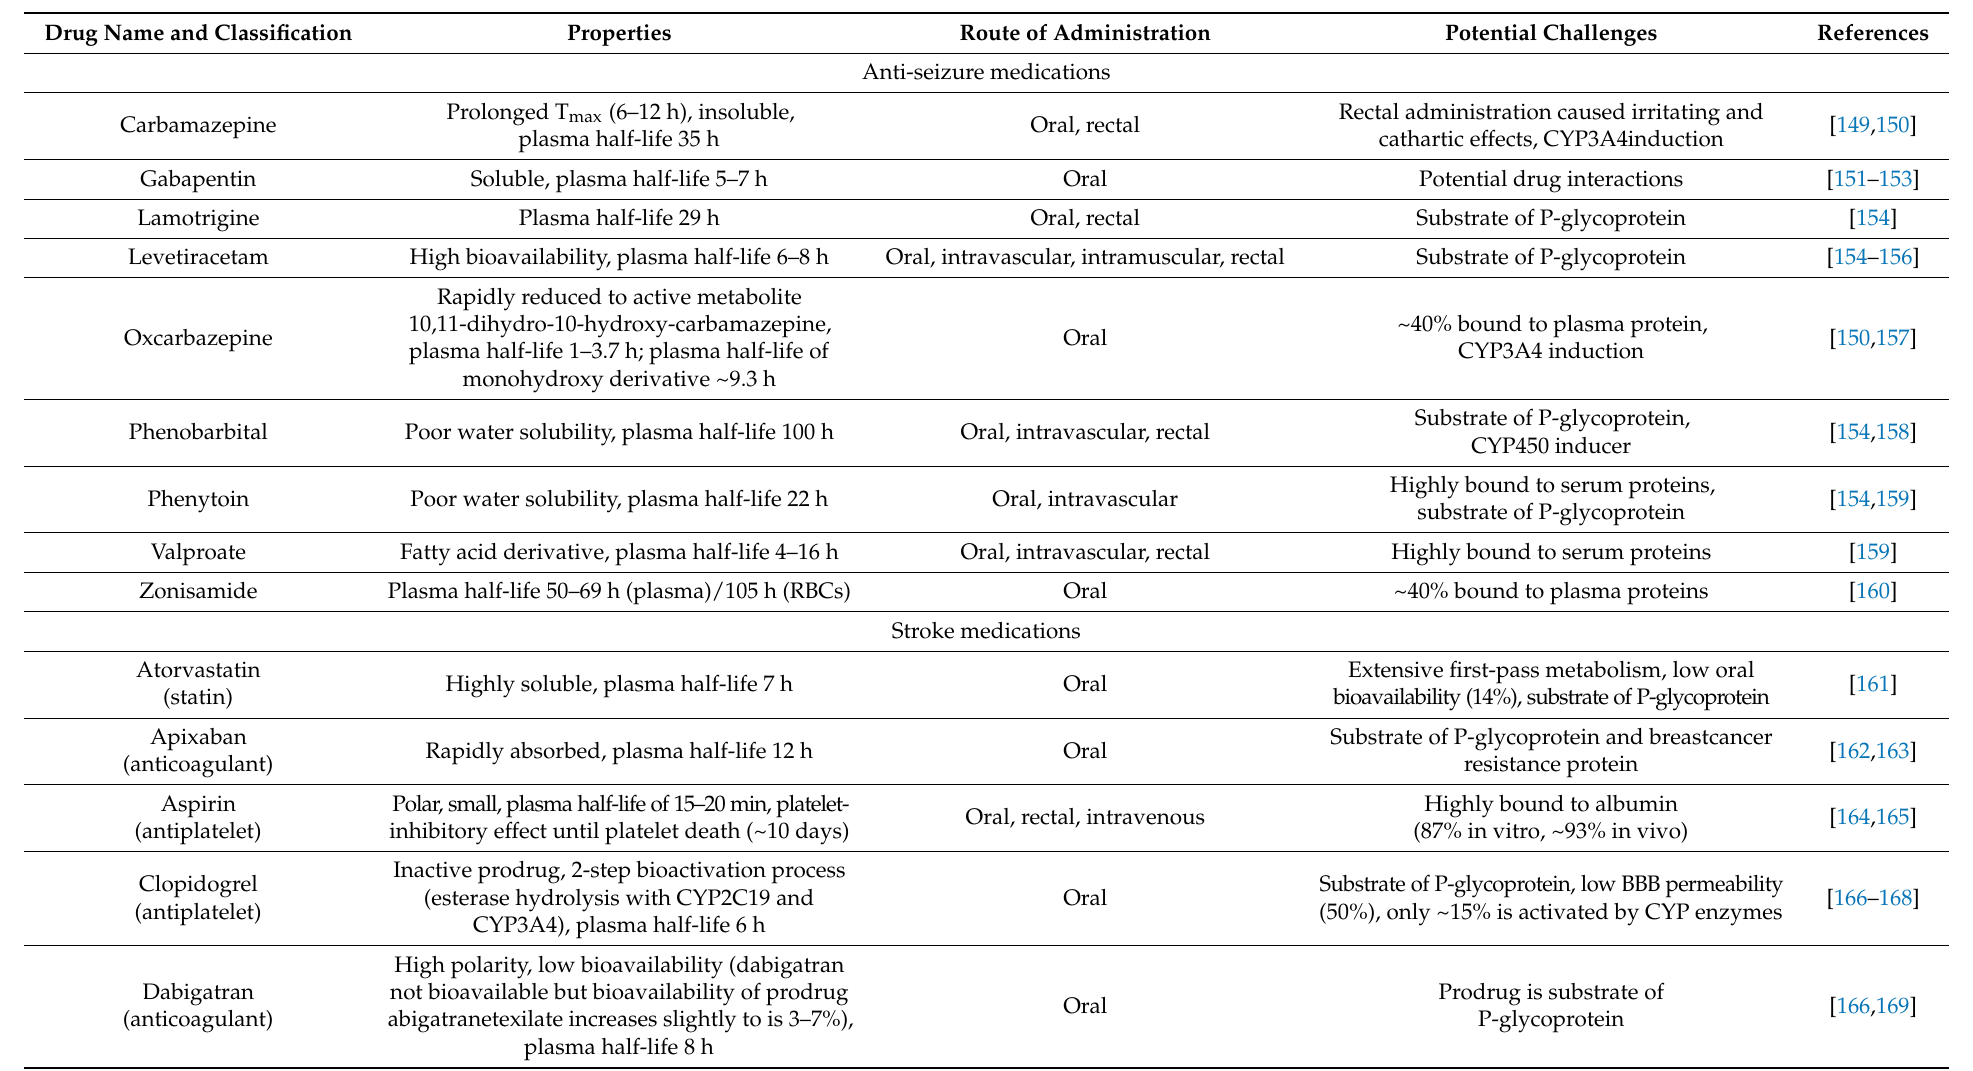
Table 2. Properties and routes of administration of selected drugs for epilepsy, stroke, cancer and traumatic brain